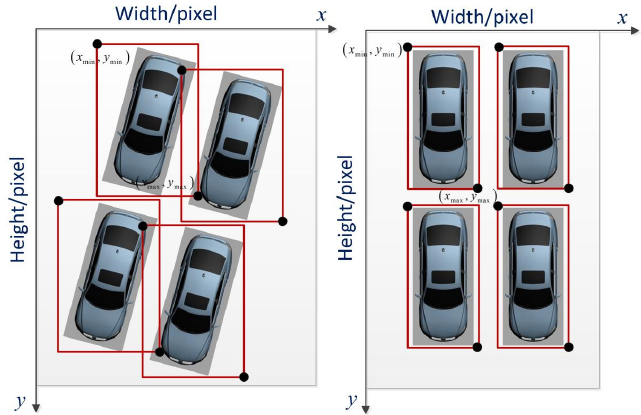
Figure 3. Position and dimensions of each parking space.